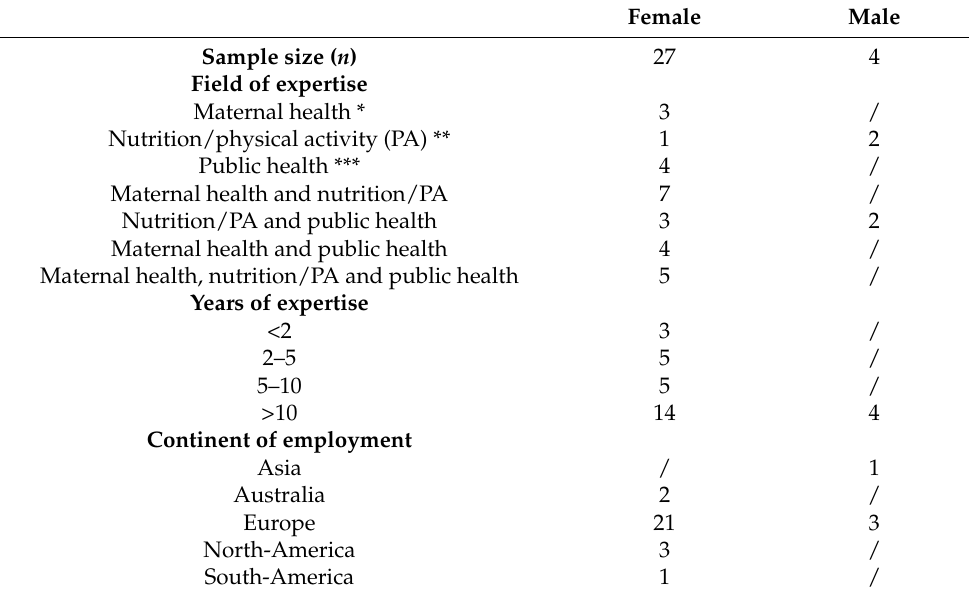
Table 2. Characteristics of the study sample of (inter)national